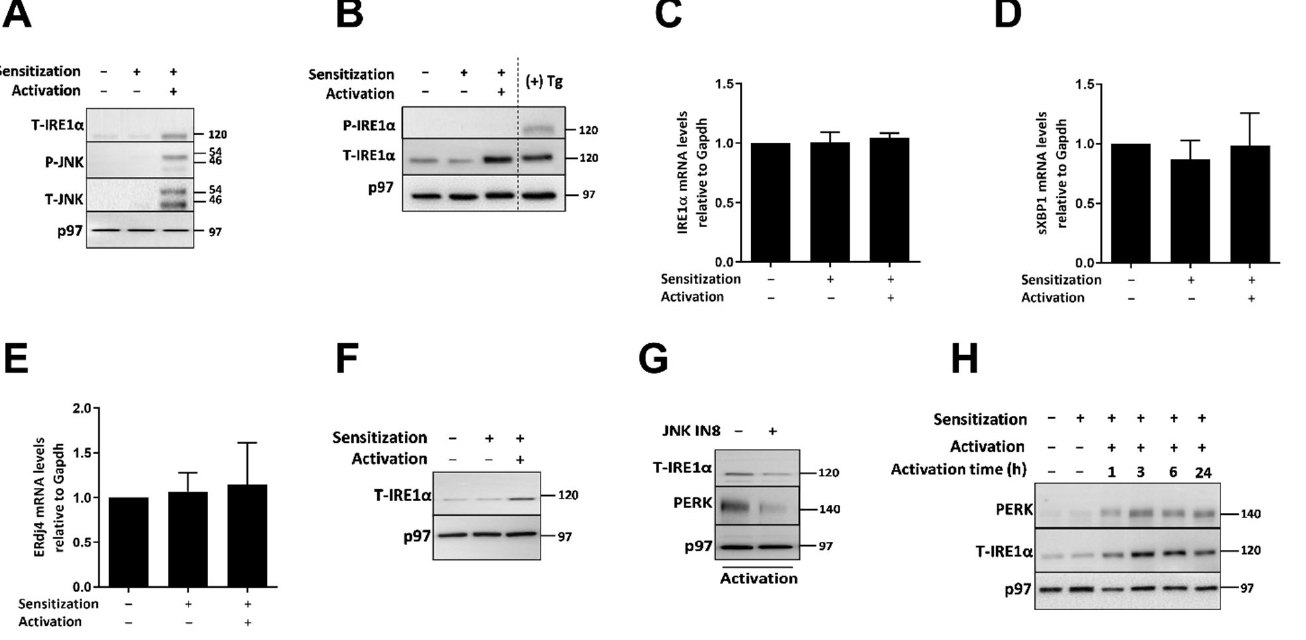
Figure 3 . PMC activation through Fc ε RI promotes expression of IRE1 α without UPR activation. ( A ) WT PMCs were sensitized with mouse IgE ‐ anti ‐ DNP (0.5 μ g/mL, 18 h) and then activated with DNP ‐ BSA (50 ng/mL, 4 h). Equal amounts of whole cell extracts were analyzed by immunoblotting for total IRE1 α , phosphorylated and total JNK, and p97 as a loading control. A typical immunoblot is shown. ( B ) WT PMCs were treated for 4 h as mentioned in ( A ) or treated with Tg (1 μ g/mL) as a positive control. Equal whole cellular protein extracts were analyzed by immunoblotting for phos ‐ phorylated and total IRE1 α , and p97 as loading control. Shown is a representative image of three independent experiments. ( C ) RT ‐ qPCR analyses of IRE1 α , ( D ) sXBP1, and ( E ) ERdj4 following 4 h of activation represented as the average of the mRNA levels normalized to GAPDH ± SD. ( F ) PMCs were sensitized with rat myeloma IgE (1 μ g/mL, 18 h) followed by activation with goat anti ‐ rat IgG F(ab’) 2 Ab (1 μ g/mL), 4 h). Identical quantity of total cellular protein extracts was analyzed by im ‐ munoblotting against total IRE1 α and p97 as a loading control. ( G ) IgE sensitized WT PMCs with IgE ‐ anti ‐ DNP (0.5 μ g/mL, 18 h) were pretreated with 3 μ M JNK ‐ IN ‐ 8 for 1 h followed by activation with DNP ‐ BSA (50 ng/mL, 4 h). An identical quantity of total cellular protein extracts was analyzed by immunoblotting against total IRE1 α , PERK, and p97 as a loading control. ( H ) WT PMCs were sensitized with mouse IgE–anti ‐ DNP (0.5 μ g/mL, 18 h), followed by activation with DNP ‐ BSA (50 ng/mL) for 1, 3, 6, or 24 h. An identical quantity of protein was analyzed by immunoblotting against PERK, total IRE1 α , and p97 as a loading control. ( I ) WT PMCs were sensitized with mouse IgE–anti ‐ DNP (0.5 μ g/mL, 18 h), followed by activation with DNP ‐ BSA (50 ng/mL) for 1, 3, and 6 h. Equal amounts of whole cell extracts were analyzed by immunoblotting for PERK, total IRE1 α , ERO1, PDI, and p97 as a loading control. ( J ) Fluorescence of ER ‐ Tracker in PMCs following IgE ‐ mediated acti ‐ vation for 4 h , analyzed by confocal microscopy at magnification of 60× with immersion oil. Mean fluorescence signal from 50 cells was quantified using ImageJ 1.53t software (U. S. National Insti ‐ tutes of Health, Bethesda, MD, USA). The average intensity and standard deviation are shown. * p < 0.05.